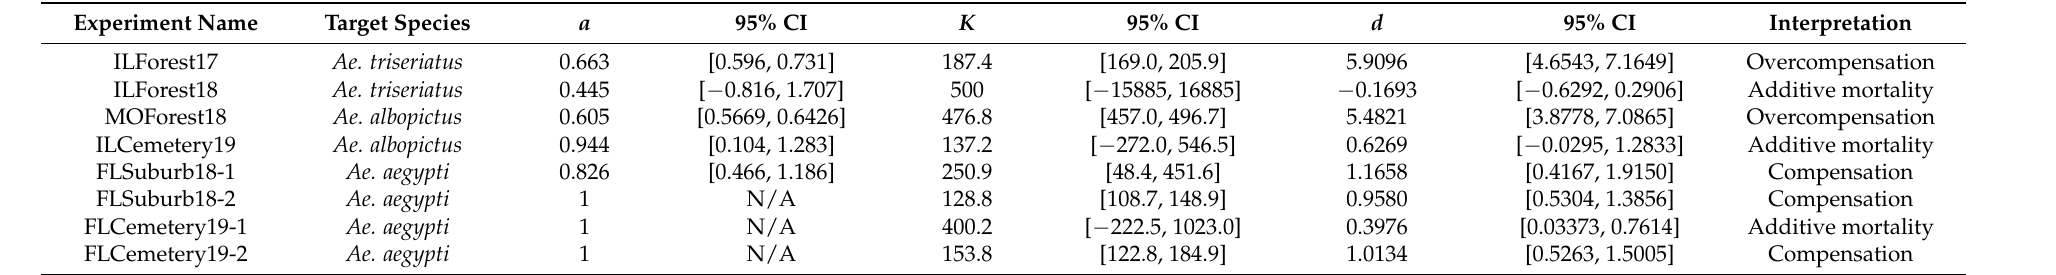
Table 3. Density manipulation experiment results. The estimated parameter values for the non-linear regression (Equation 1) are reported for each experiment, respectively. The interpretations of the results are based on the parameter d and are reported in the last column. d < 1 additive mortality; d = 1 compensation; d > 1 overcompensation. N/A indicates that confidence intervals for the associated parameter could not be estimated, usually because the solution converged to an estimate of the upper bound for the parameter (i.e., FLSuburb18-2, FLCemetery19-1, and FLCemetery19-1